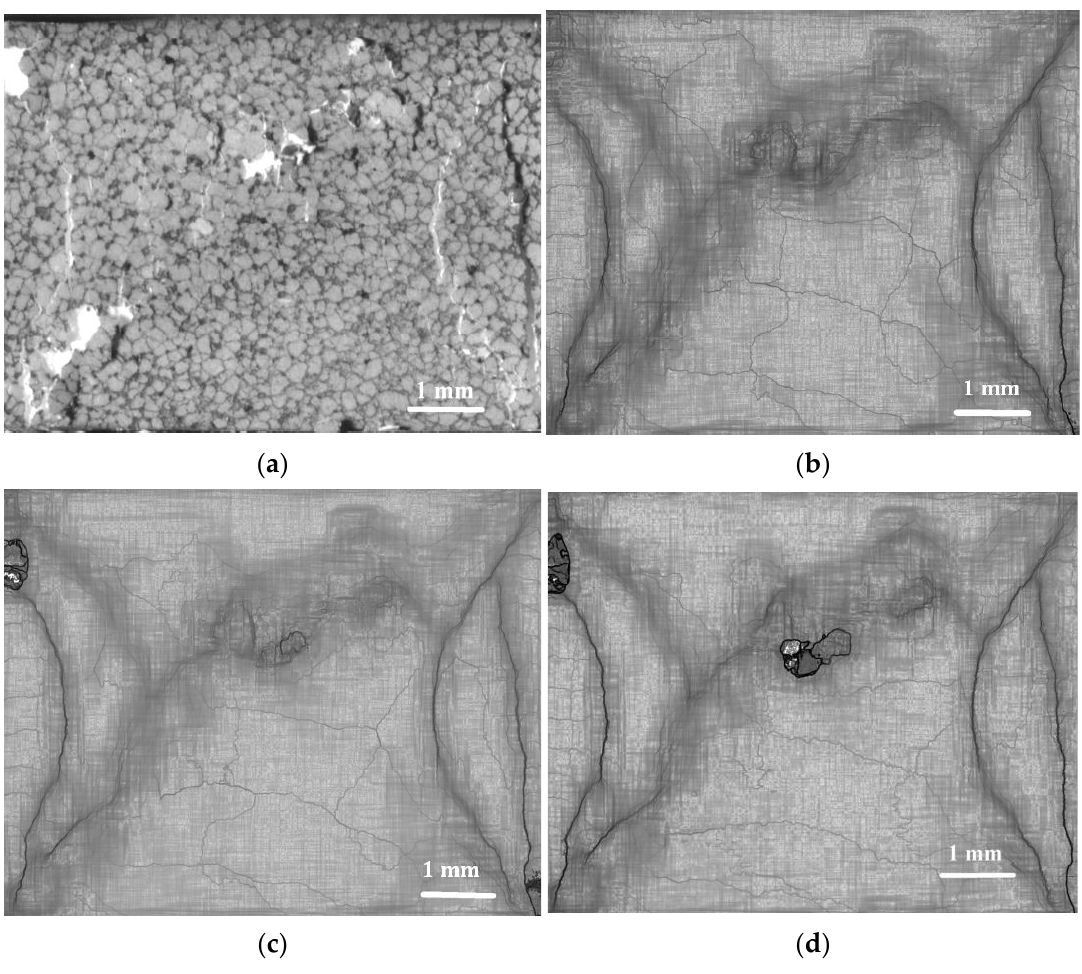
Figure 14. Optical macrograph ( a ) and deformation maps ( b – d ) of Sample #1 at the deformation Stage IV at strain are as follows: ε = 0.085 ( a ), ε = 0.077, ∆ ε = 0.010 ( b ), ε = 0.079, ∆ ε = 0.010 ( c ), and ε = 0.081, ∆ ε = 0.010 ( d